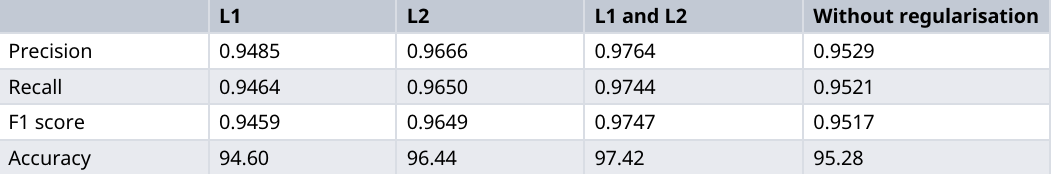
Table 5. Performance of MSTCN using different regularisation settings.